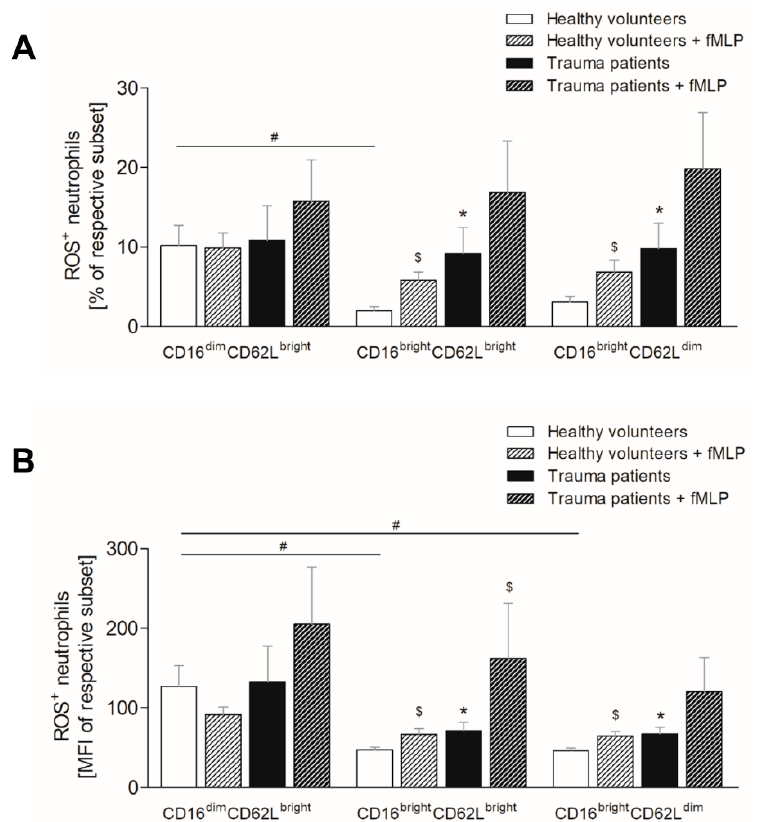
Figure 4. Impact of severe traumatic injury on generation of reactive oxygen species (ROS) by neutrophil subsets. The ( A ) percentage and ( B ) mean intensity of ROS positive CD16 dim CD62L bright (immature), CD16 bright CD62L bright (mature) and CD16 bright CD62L low (CD62L dim ) neutrophils were determined in healthy subjects (white bars) and severely injured patients (black bars) within 12 h postinjury. Whole blood was stimulated with PMA ex vivo (diagonally striped bars). Data are presented as mean ± standard error of the mean. *: p < 0.05 vs. healthy volunteers; #: p < 0.05 vs. respective subset; $: p < 0.05 vs. unstimulated corresponding subset.